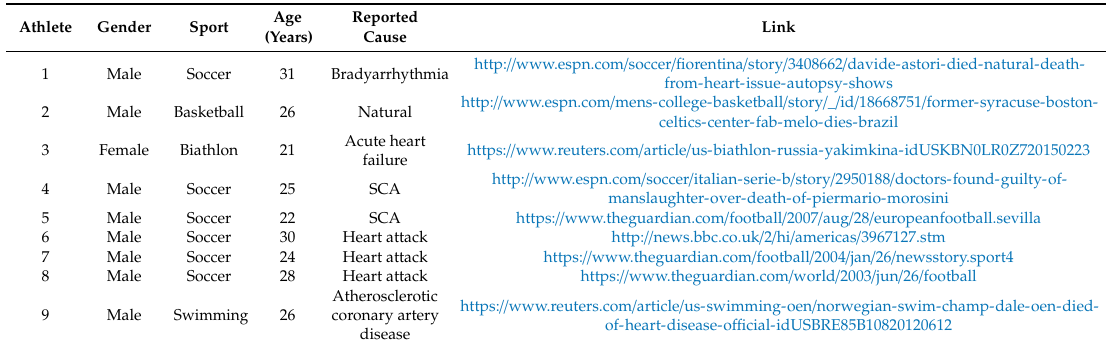
Table 1. News reporting sudden death associated to the sport practice ( n = 16) with great media repercussion and cause of death (Google’s